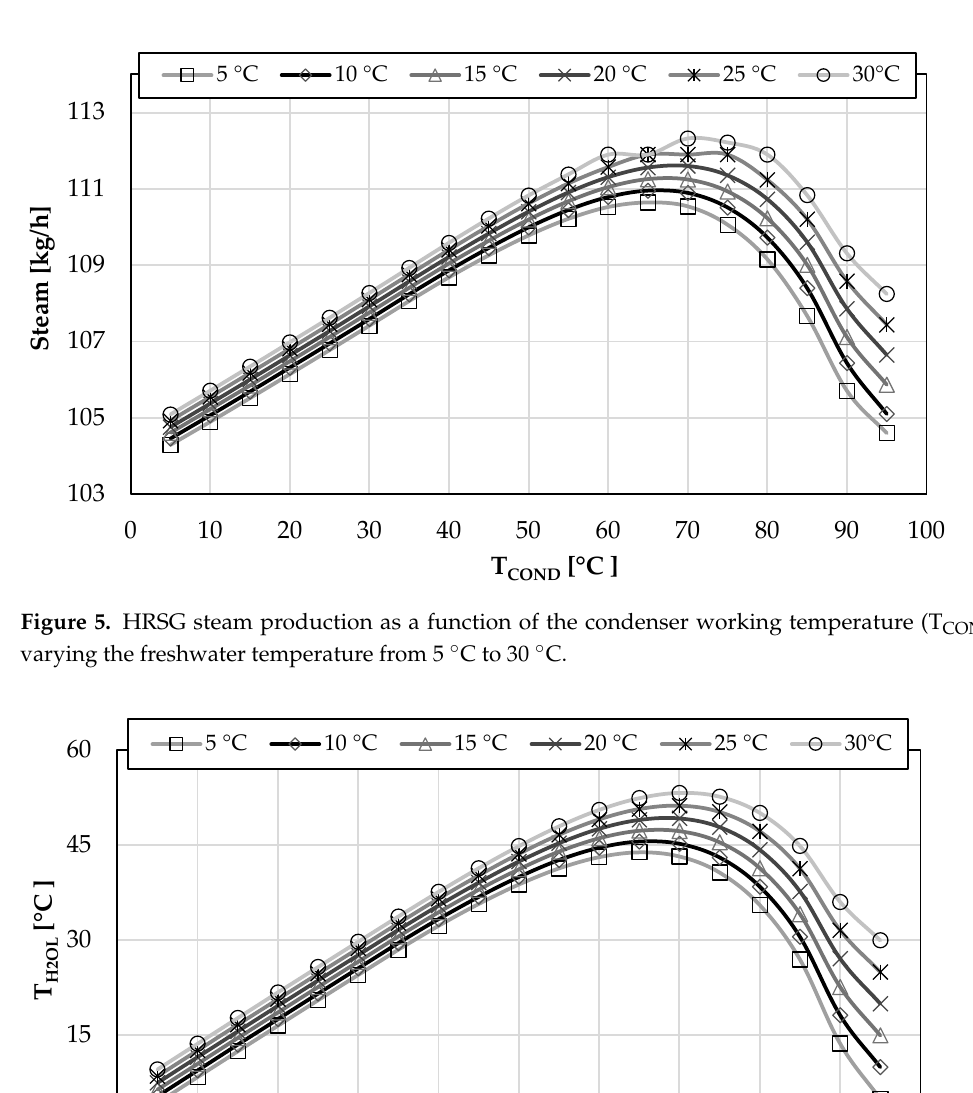
Figure 4. Condensate stream as a function of the condenser working temperature (T COND ).